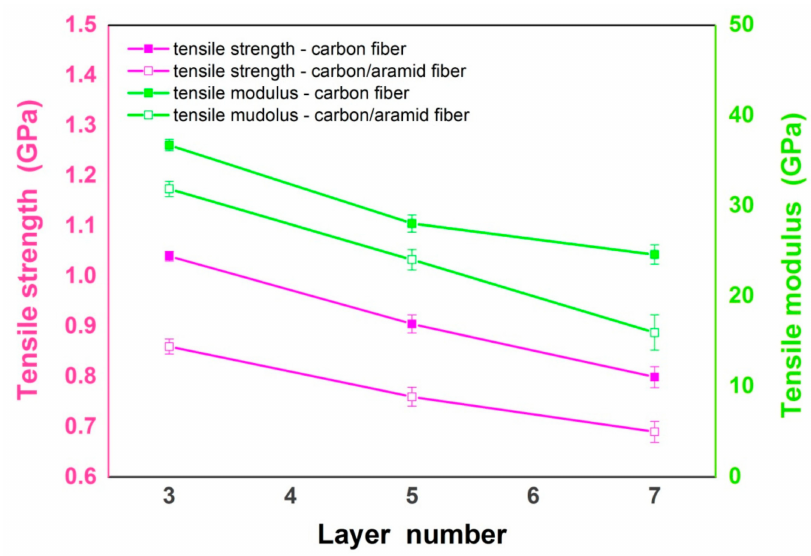
Figure 4. Tensile performance of carbon fiber / epoxy composites and carbon-aramid fiber / epoxy sandwich composites with di ff erent layer